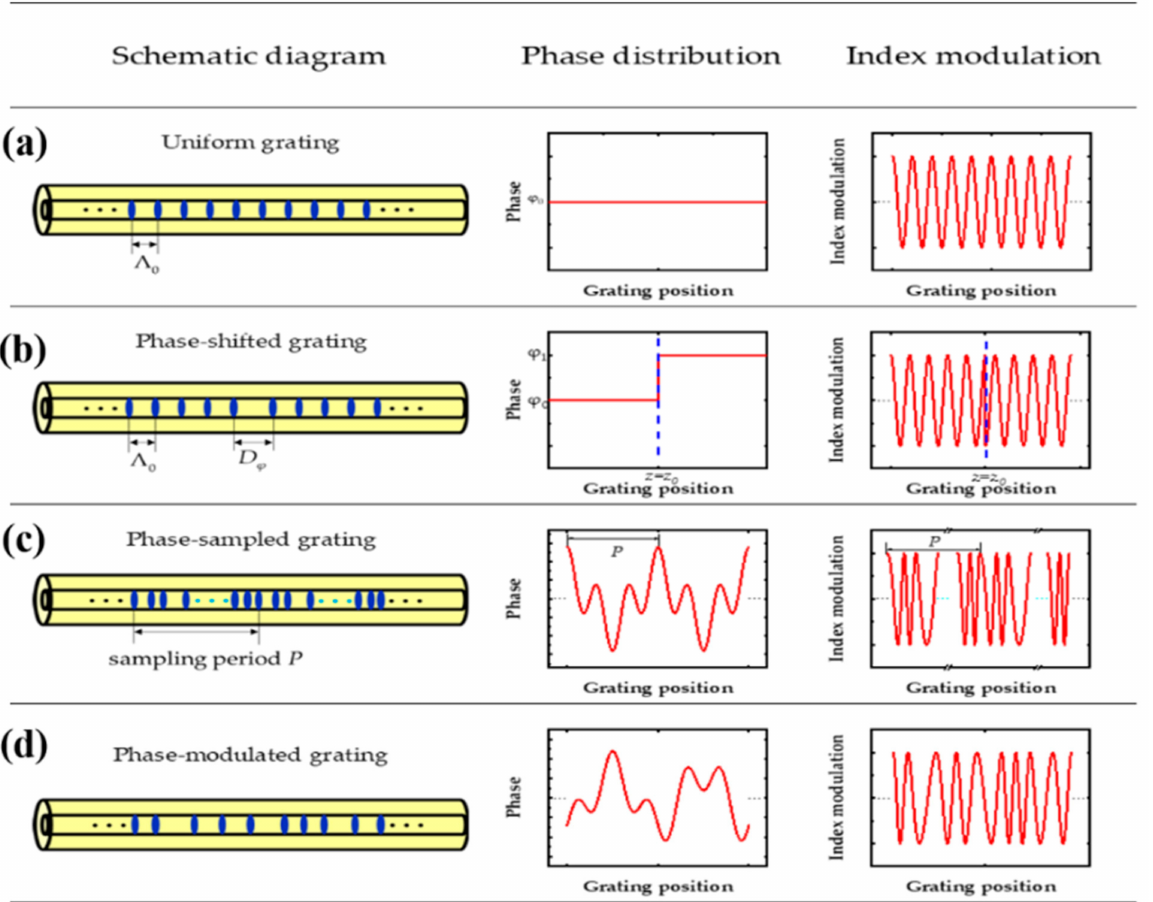
Figure 1. Schematic diagrams, phase distributions, and index-modulations of ( a ) the conventional, ( b ) the phase-shifted, ( c ) the phase-only sampled, and ( d ) the phase-modulated fiber gratings. To date, as results of the proposed PI-FGs where the numbers, quantities, and positions of the inserted phase-shifts along the fiber direction are suitably selected with a